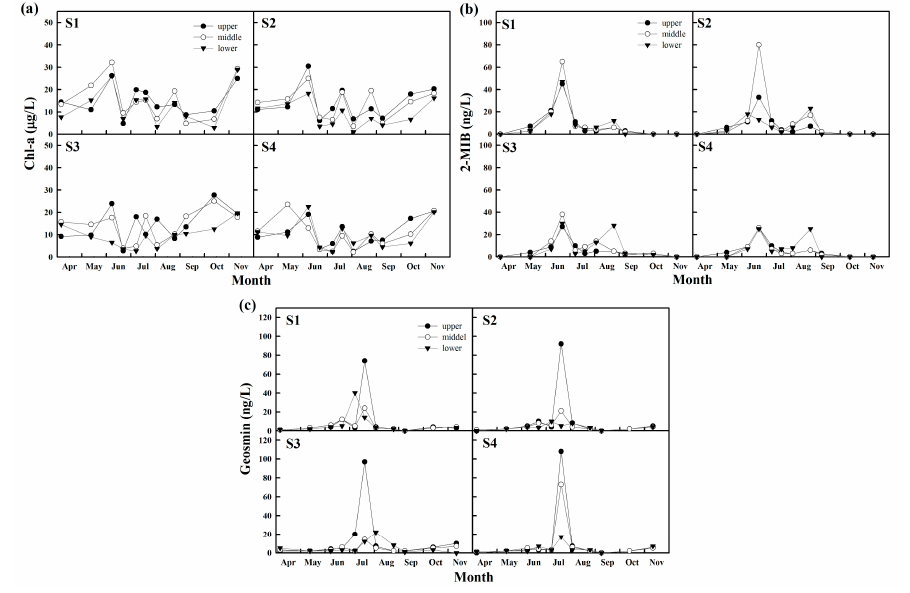
Figure 3. Observed concentrations of ( a ) chlorophyll-a (Chl-a), ( b ) 2-methylisoborneol (2-MIB), and ( c ) geosmin in the upper, middle, and lower layers of each monitoring point in the Jinyang Reservoir.